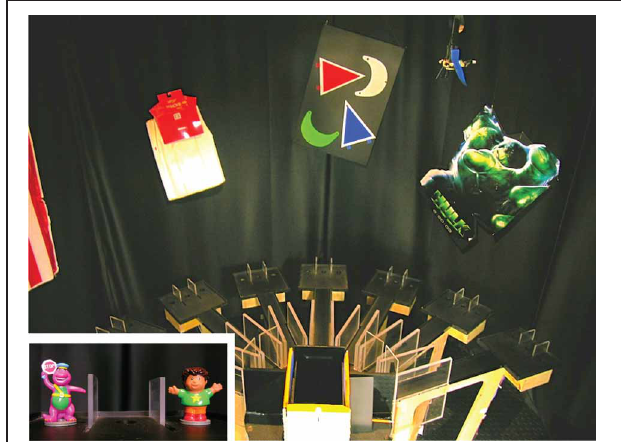
FIGURE 7 | A contextual item-selection task. The task requires the rat to choose one of the objects (inset: toy figures) depending on where in the maze the two objects appear. The surrounding visual cues on the curtains serve as a visual